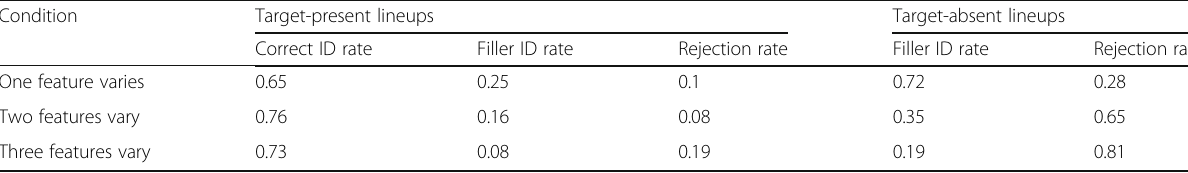
Table 2 Number of identifications and rejections from Experiment 1